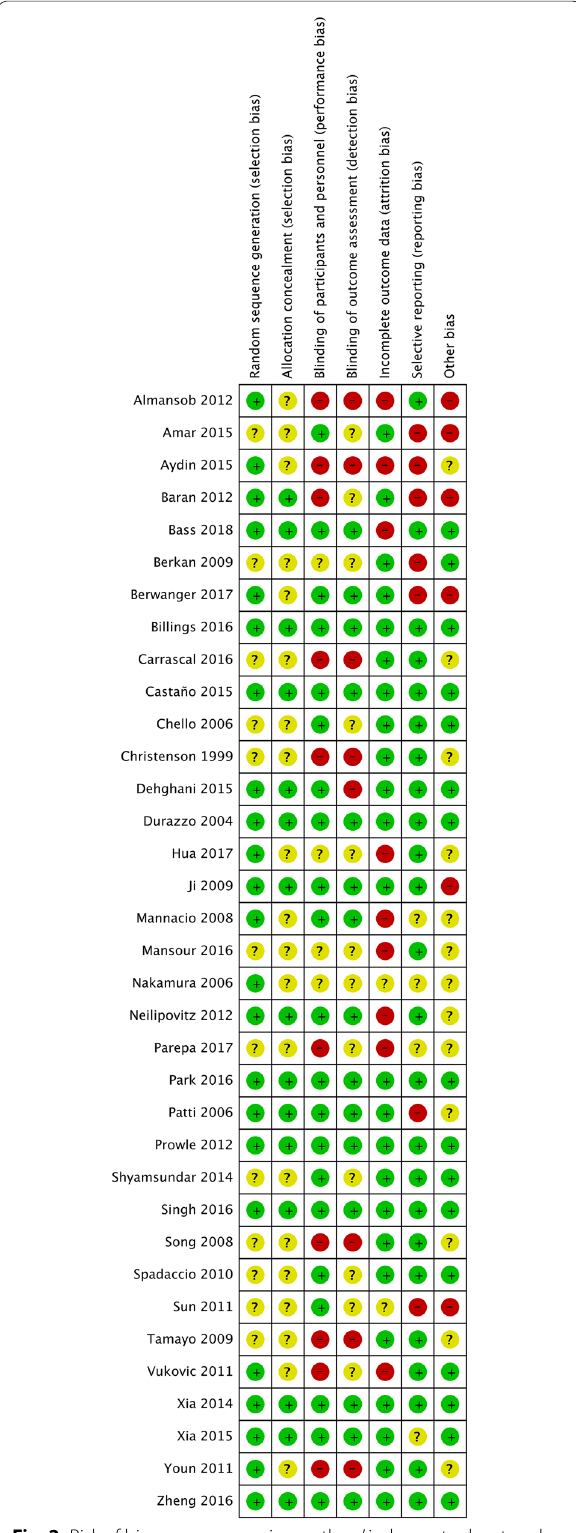
Fig. 2 Risk of bias summary: review authors’ judgments about each risk of bias item for each included